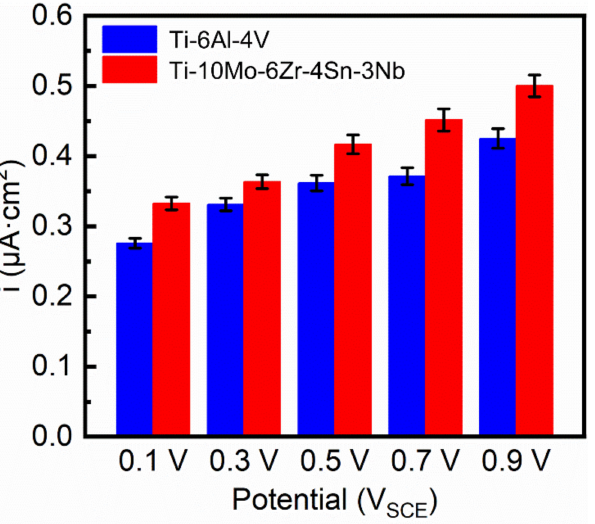
Figure 6. Quasi-steady state current density for Ti–10Mo–6Zr–4Sn–3Nb and Ti–6Al–4V at various applied potentials after 30 min potentiostatic polarization in Hank’s solution at 37 ◦